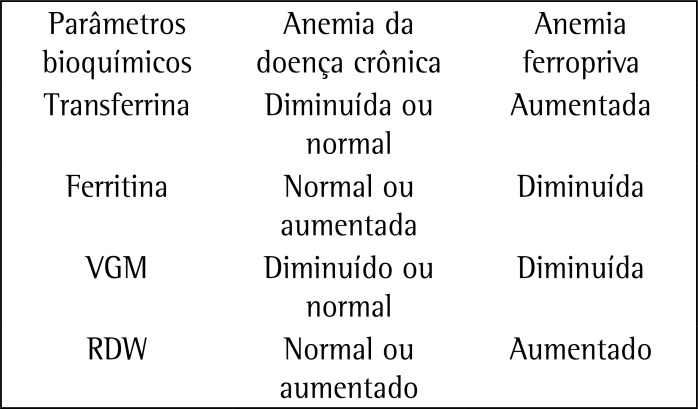
Parâmetros para a avaliação dos tipos de anemia estudados. VGM: volume
globular médio; e RDW: red blood cell distribution width (índice de
anisocitose eritrocitária).